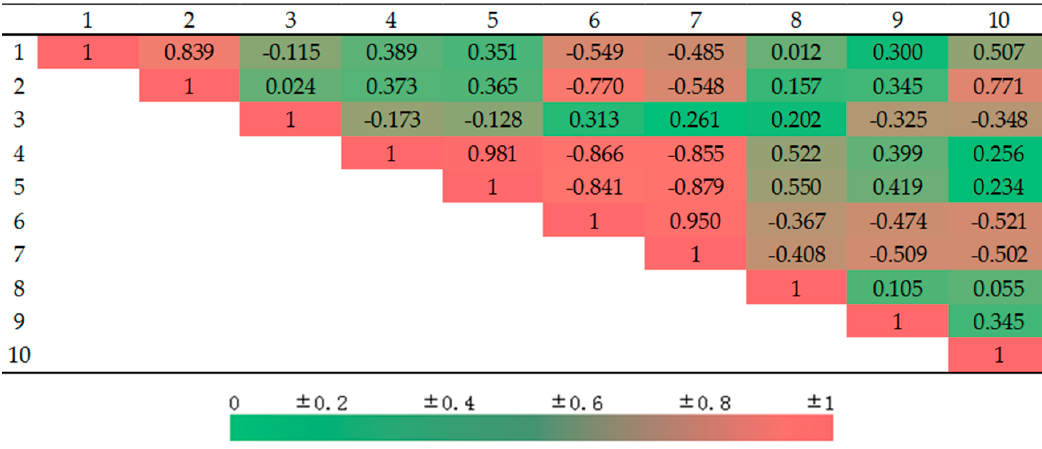
Figure 4. Spearman correlation analysis coefficient ρ .